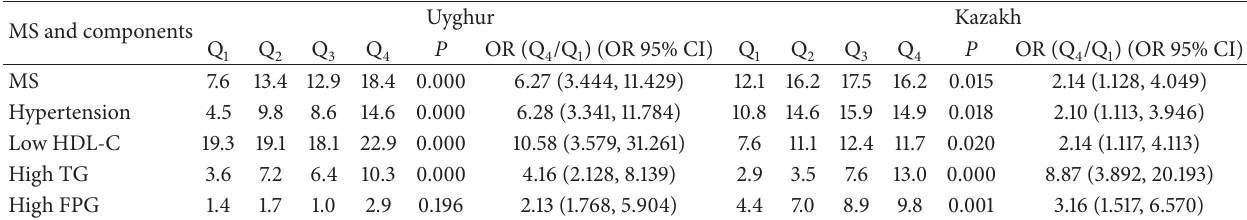
Table 3: Detection rates of MS and components in each IL-6 level quartile.